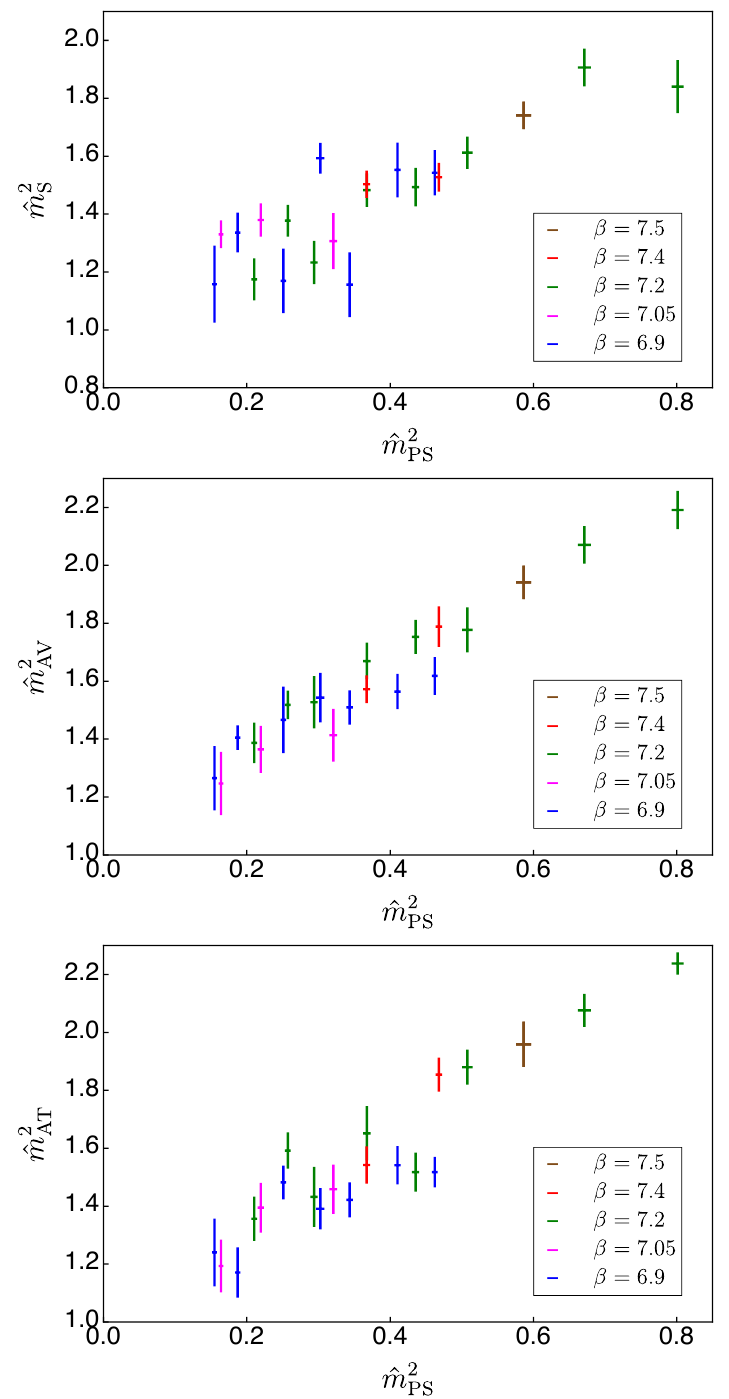
Figure 9. Mass squared of mesons sourced by scalar (S, top), axial-vector (AV, middle) and axial-tensor (AT, bottom) operators as a function of the pseudoscalar mass squared ^ m 2 colours refer to di(cid:11)erent lattice couplings as shown in the legends. The error bars represent the size of statistical uncertainties. (See appendix A.3 for the details.)